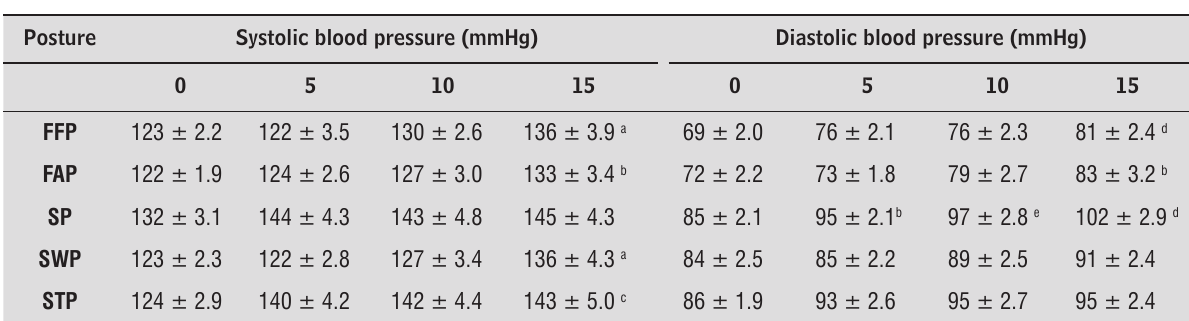
Table 1 - Mean and standard error of systolic and diastolic blood pressure at 0, 5, 10 and 15 min during the postures frog on the floor (FFP), frog in the air (FAP), sitting (SP), standing against the wall (SWP) and standing with anterior tilt